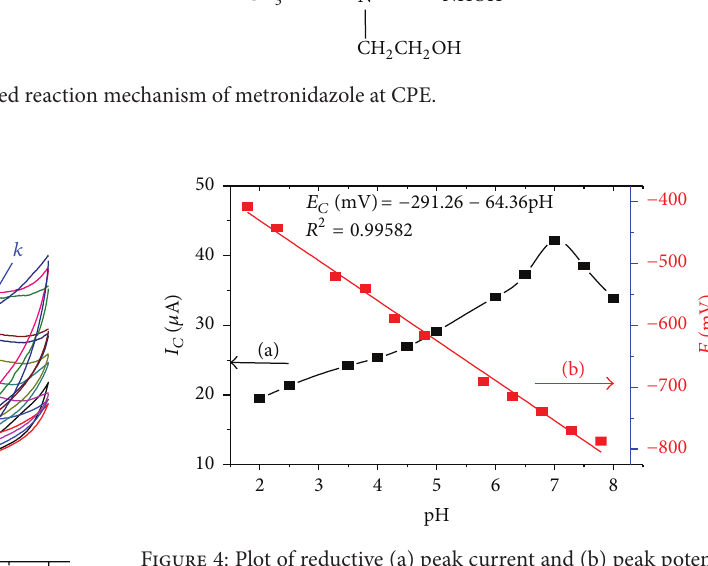
Figure 4: Plot of reductive (a) peak current and (b) peak potential versus pH for 1mM MTZ in 0.1M BRB solution of different pH values at CPE. Scan rate: